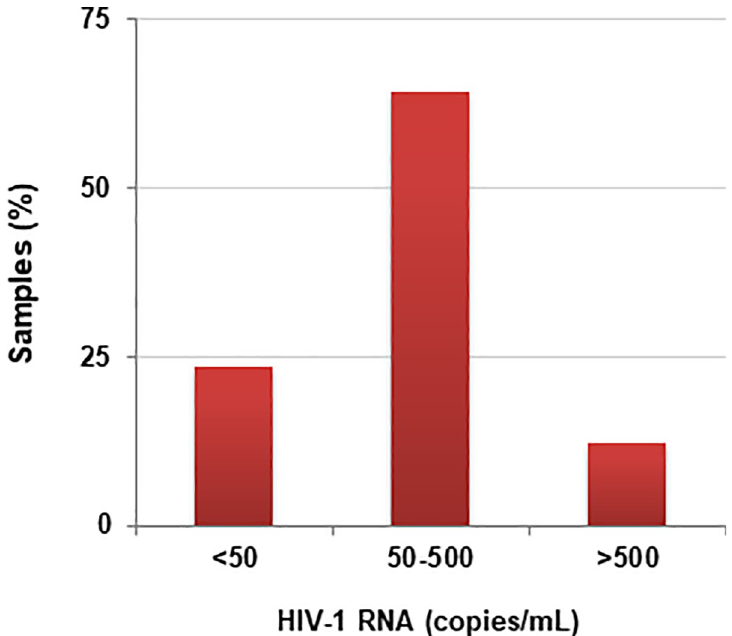
Fig 1. Distribution of samples (n = 148) that were quantified with the LTR signal according to HIV-1 RNA ranges ( < 50 copies/mL; 50–500 copies/mL; > 500 copies/mL) by Aptima.